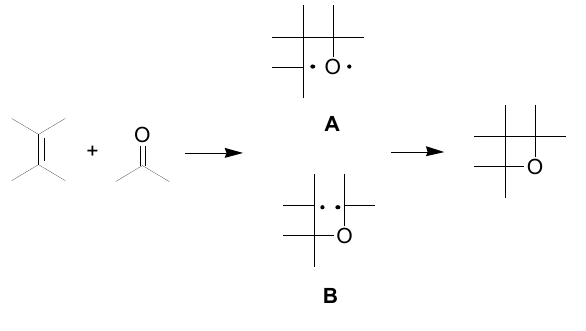
Scheme 2. Possible mechanisms of the Paternò-Büchi